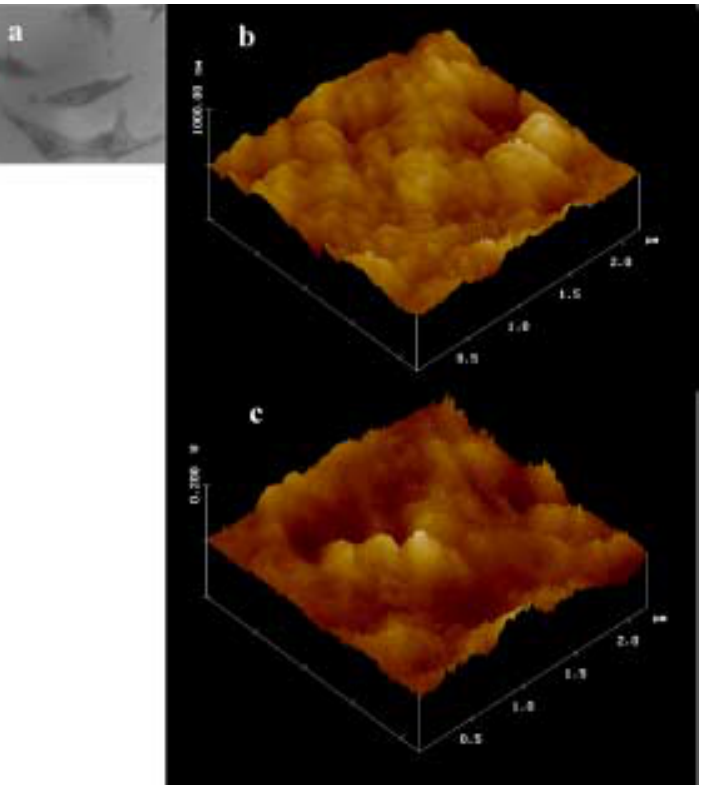
Fig. 5. (a) Far-field image of cells of the breast cancer cell line T-47D (after 48 hours treatment with 5 × 10 − 5 M E 2 ) detected with 40 × magnification; typical spindle like shape is visible. (b) Near-field topographic image of a cellular surface section of the breast cancer cell indicated in (a) by an arrow; only intimated rosettes are visible; (c) near-field transmission light image of the same surface section. Regions of the rosettes do not correspond to low absorbance regions.